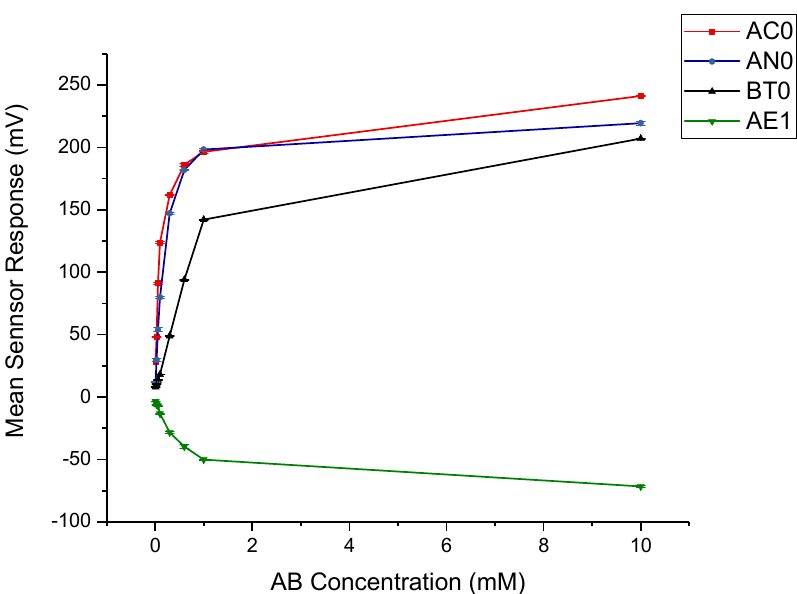
Figure 2. Dose response curve representing initial taste for amlodipine besylate as tested by AC0, AN0, BT0 and AE1.